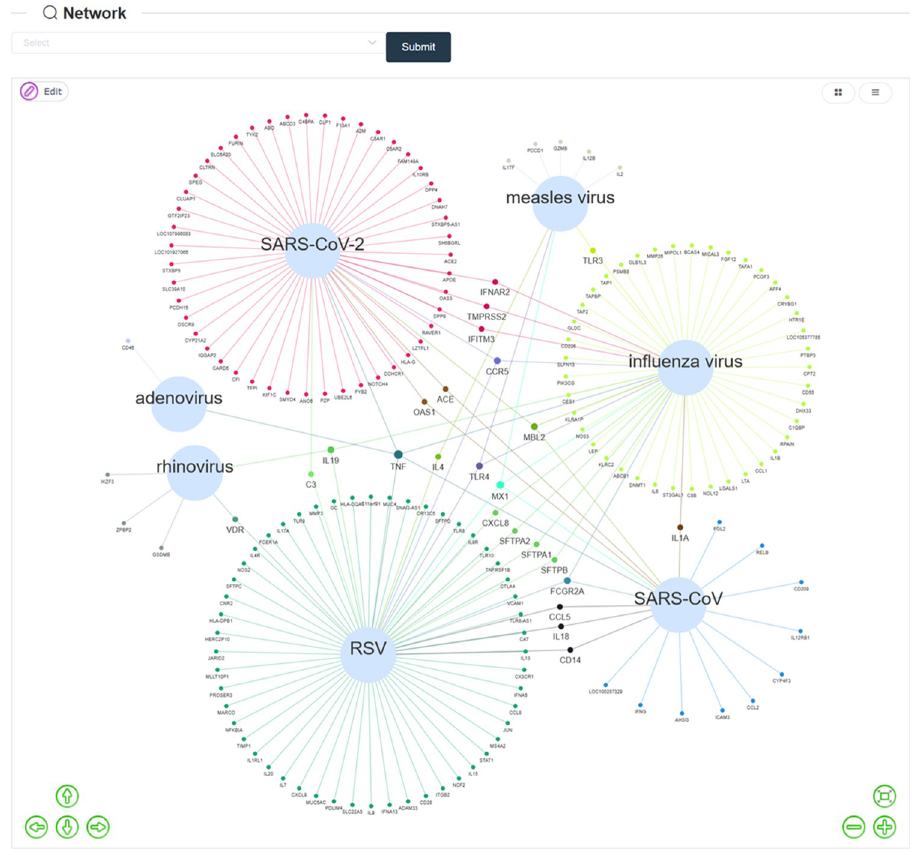
Fig 2. Network page provides a visual overview of the topological relationship between respiratory viruses and associated genes. Nodes represent respiratory viruses and genes. Respiratory virus node and gene node are linked by an edge if at least one variant on the gene are reported to be associated with the susceptibility or severity of the virus. Genes associated with more than one virus are highlighted by larger label